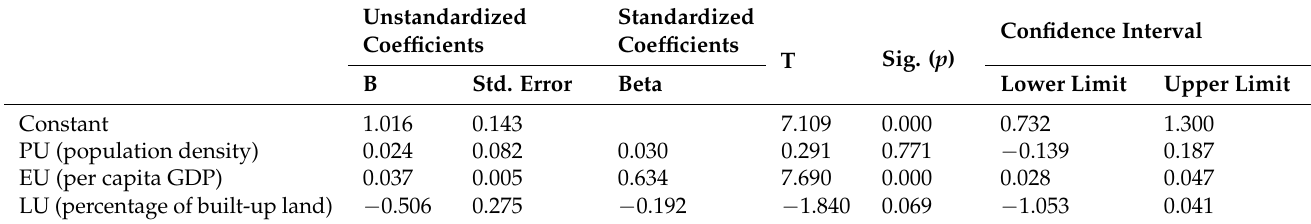
Table 5. Summary for multiple linear